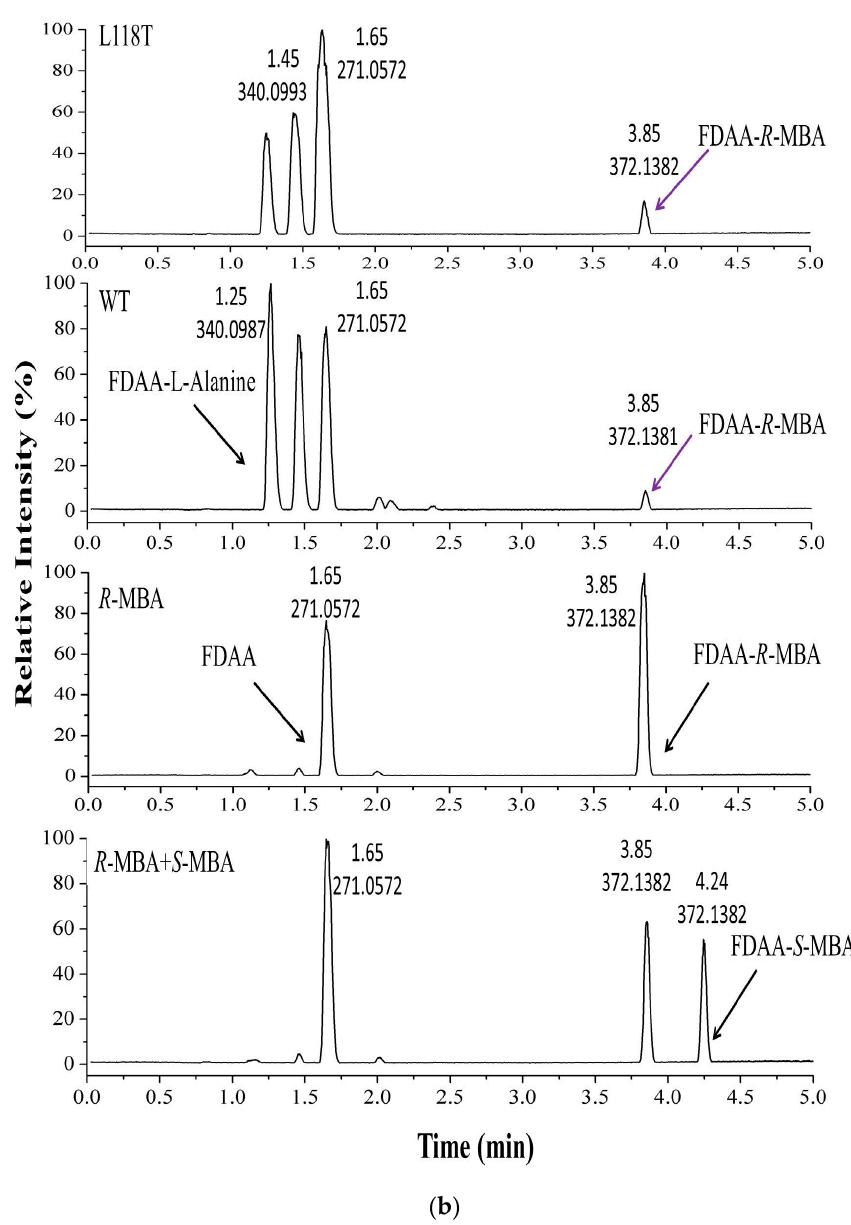
Figure 4. The extracted ion chromatogram (EIC) of Marfey’s derivatives obtained from the transamination reaction with AT-ATA and its mutant: The reaction conditions were 30 mM acetophenone; ( a ) 120 mM 2-butylamine or ( b ) 120 mM L -alanine; 10 U/mL lactate dehydrogenase (LDH); 10 mM nicotinamide adenine dinucleotide (NADH); 0.2 mg/mL purified enzyme; and 24 h reaction.